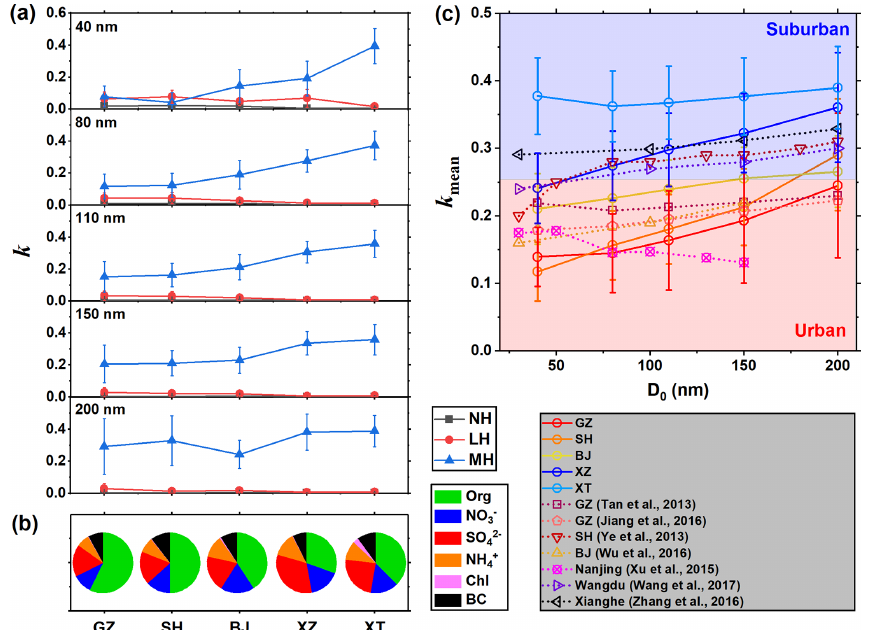
Figure 10. (a) Size-resolved mean hygroscopicity parameters ( κ ) that are nearly hydrophobic (NH), less hygroscopic (LH), and more hygroscopic (MH) for all measured particle sizes at different sites. (b) Campaign-averaged bulk mass fraction of chemical compositions of PM 2 . 5 . The BC mass concentration of the GZ site is based on the data measured in January 2020 due to the lack of observations in November 2019. (c) Size-dependent mean κ for all measured particle sizes retrieved from the H-TDMA measurements at different sites and reported by previous studies (Tan et al., 2013; Jiang et al., 2016; Ye et al., 2013; Wu et al., 2016; Xu et al., 2015; Wang et al., 2017; Zhang et al., 2016). The error bars represent ± 1 σ